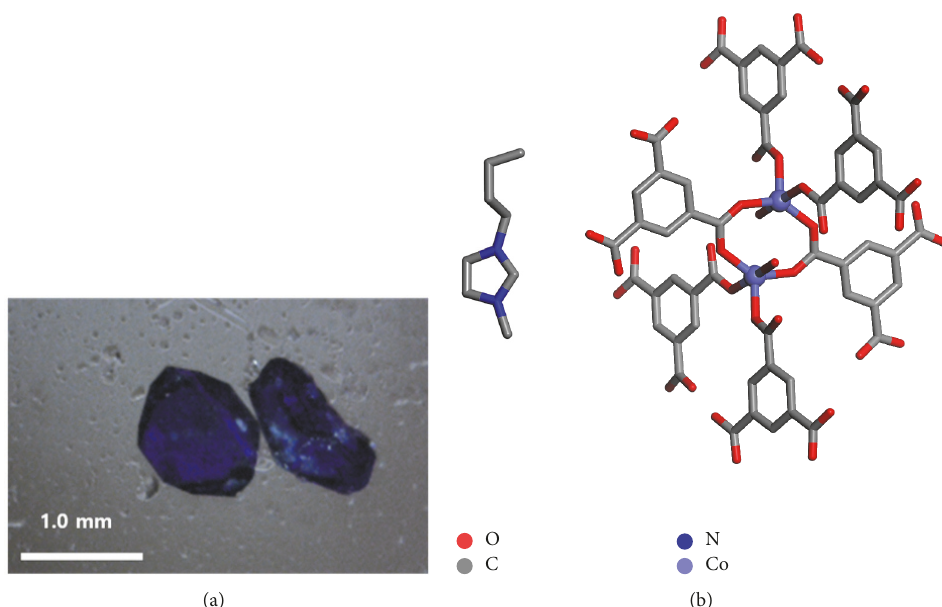
Figure 1: (a) Crystal image of synthesized [BMI] 2 [Co 2 (BTC) 2 (H 2 O) 2 ] crystals. (b) Molecular models depicting the incorporated cations and the secondary building units (SBUs) of [BMI] 2 [Co 2 (BTC) 2 (H 2 O) 2 ].